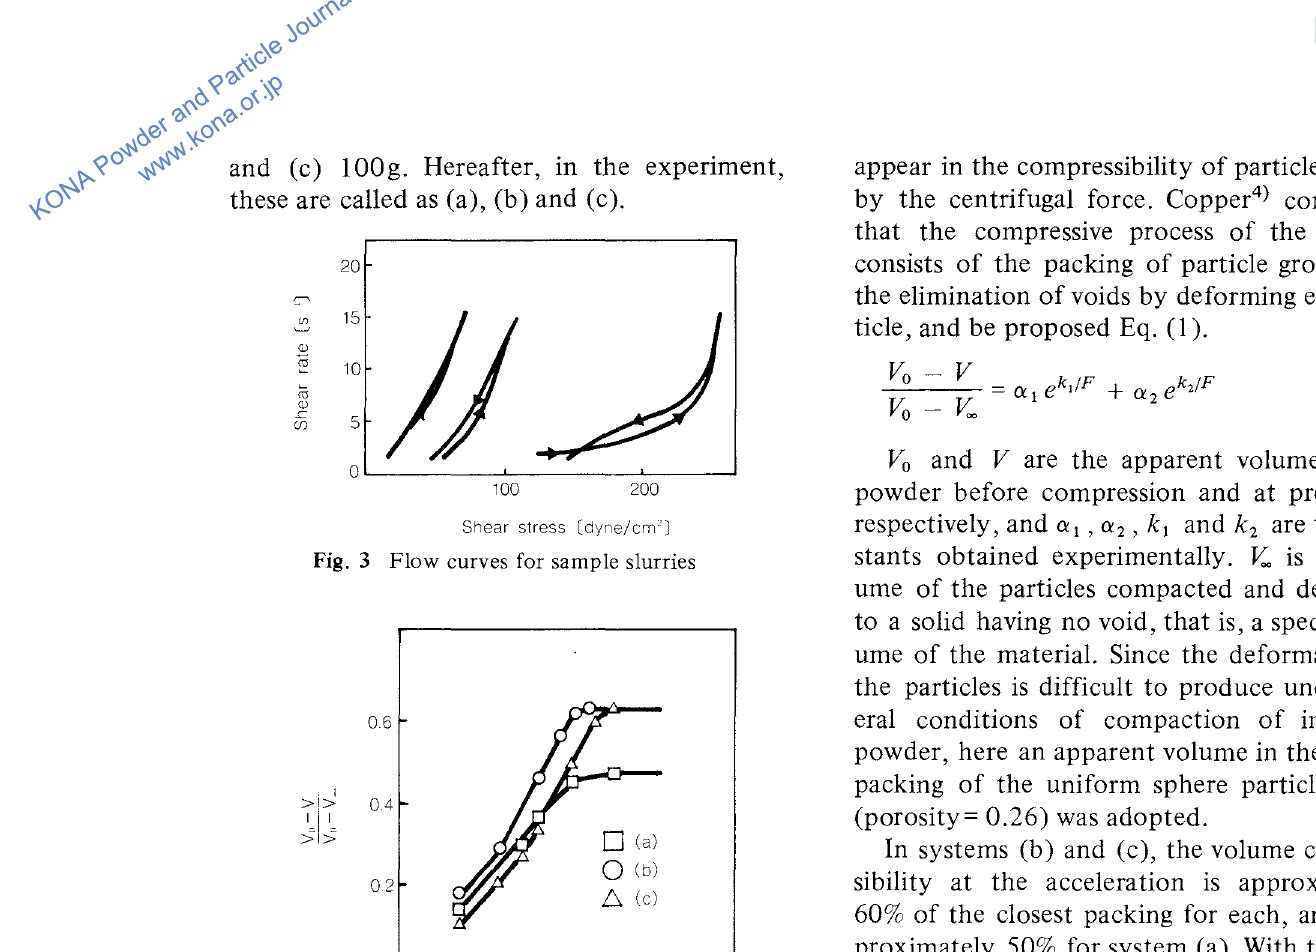
Fig. 3 Flow curves for sample slurries